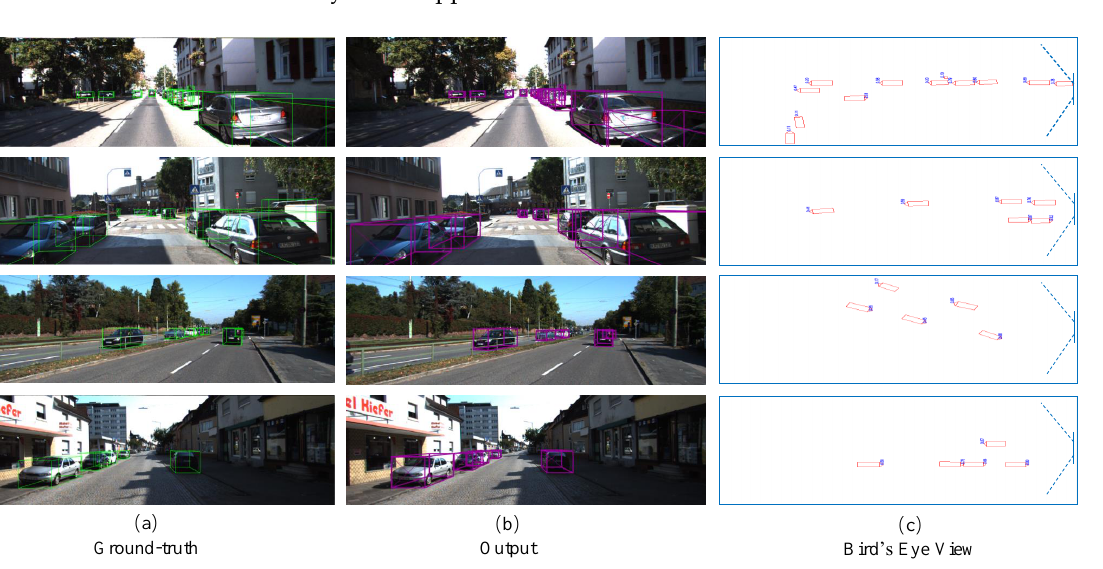
Figure 4. Visualization of car category detection in four scenes. In each picture group, we show the ground-truth ( a ), the output ( b ) and the bird’s eye view ( c ) from the left to the